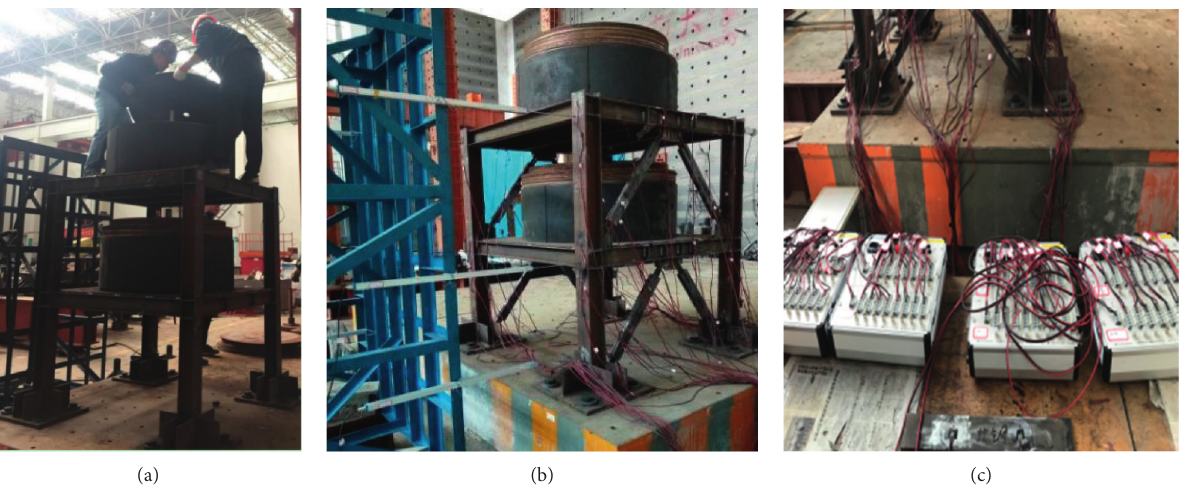
Figure 9: Layout of measuring instrument. (a) Placement of mass block. (b) Displacement sensor. (c) Data acquisition